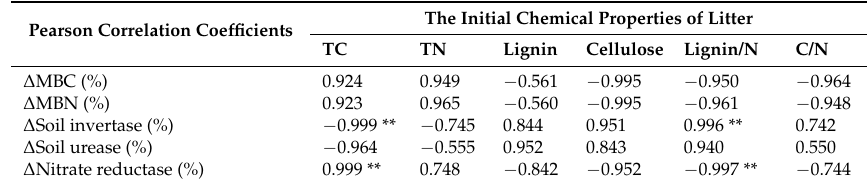
Table 3. Pearson correlation coefficients between the initial chemical properties of litter and the indicators of soil biological properties.